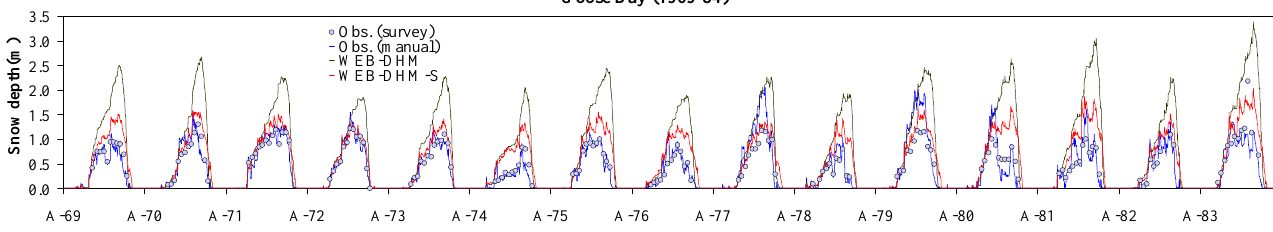
Fig. 3. Comparison of observed and simulated mean daily snow depth at GSB (1969–1984). Table 4. BIAS in simulating the first, maximum, minimum during the mid season, one prior to last and last SWE observations at the CDP, WFJ and SLR sites. First Maximum Minimum during One prior to last Last the mid season Site WEB- WEB- WEB- WEB- WEB- WEB- WEB- WEB- WEB-